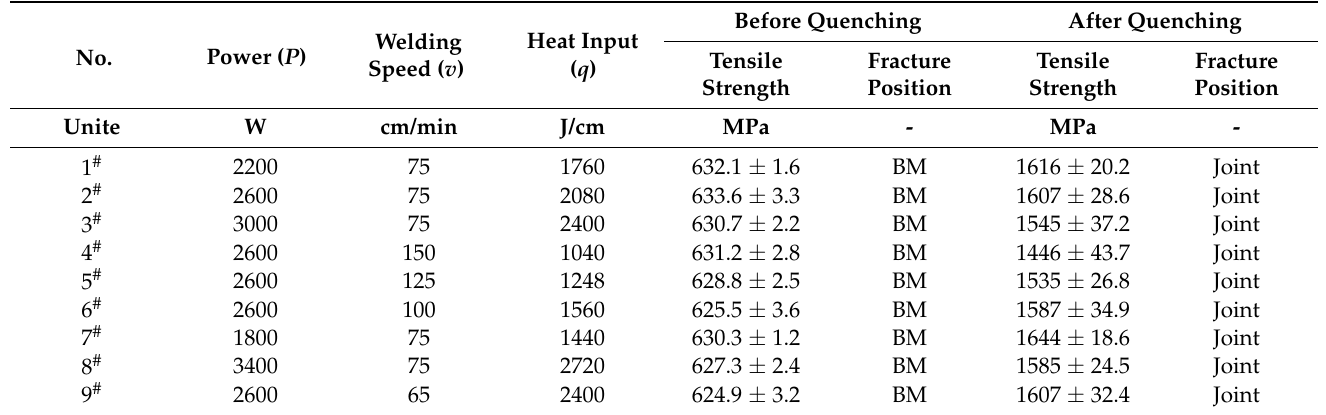
Table 3. Tensile test results of all the samples before and after